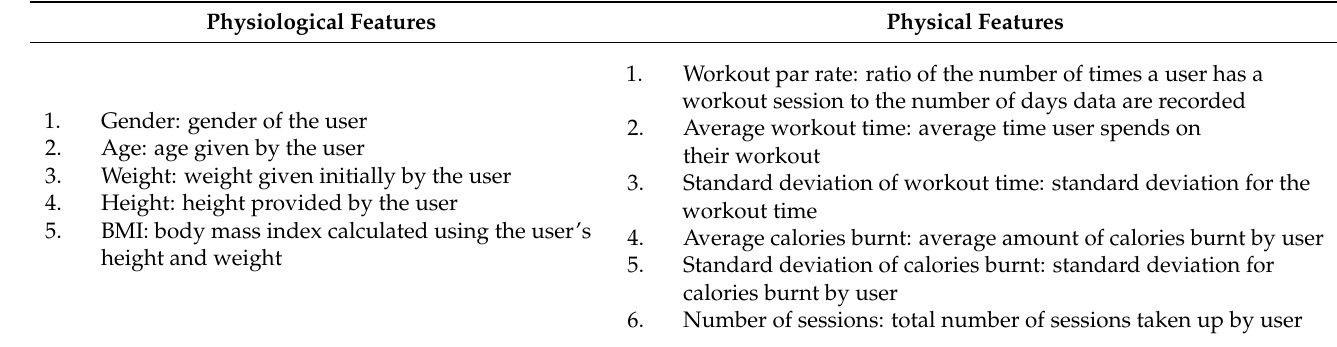
Table 1. Definition of physiological and physical features.